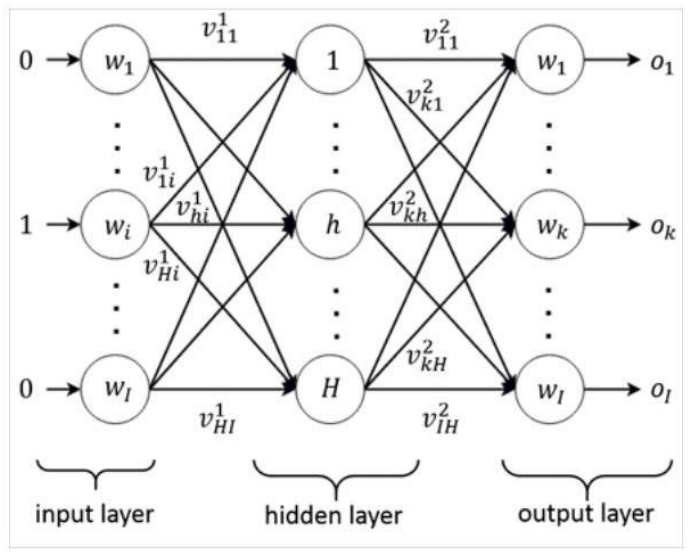
Figure 1. The Word2Vec network.